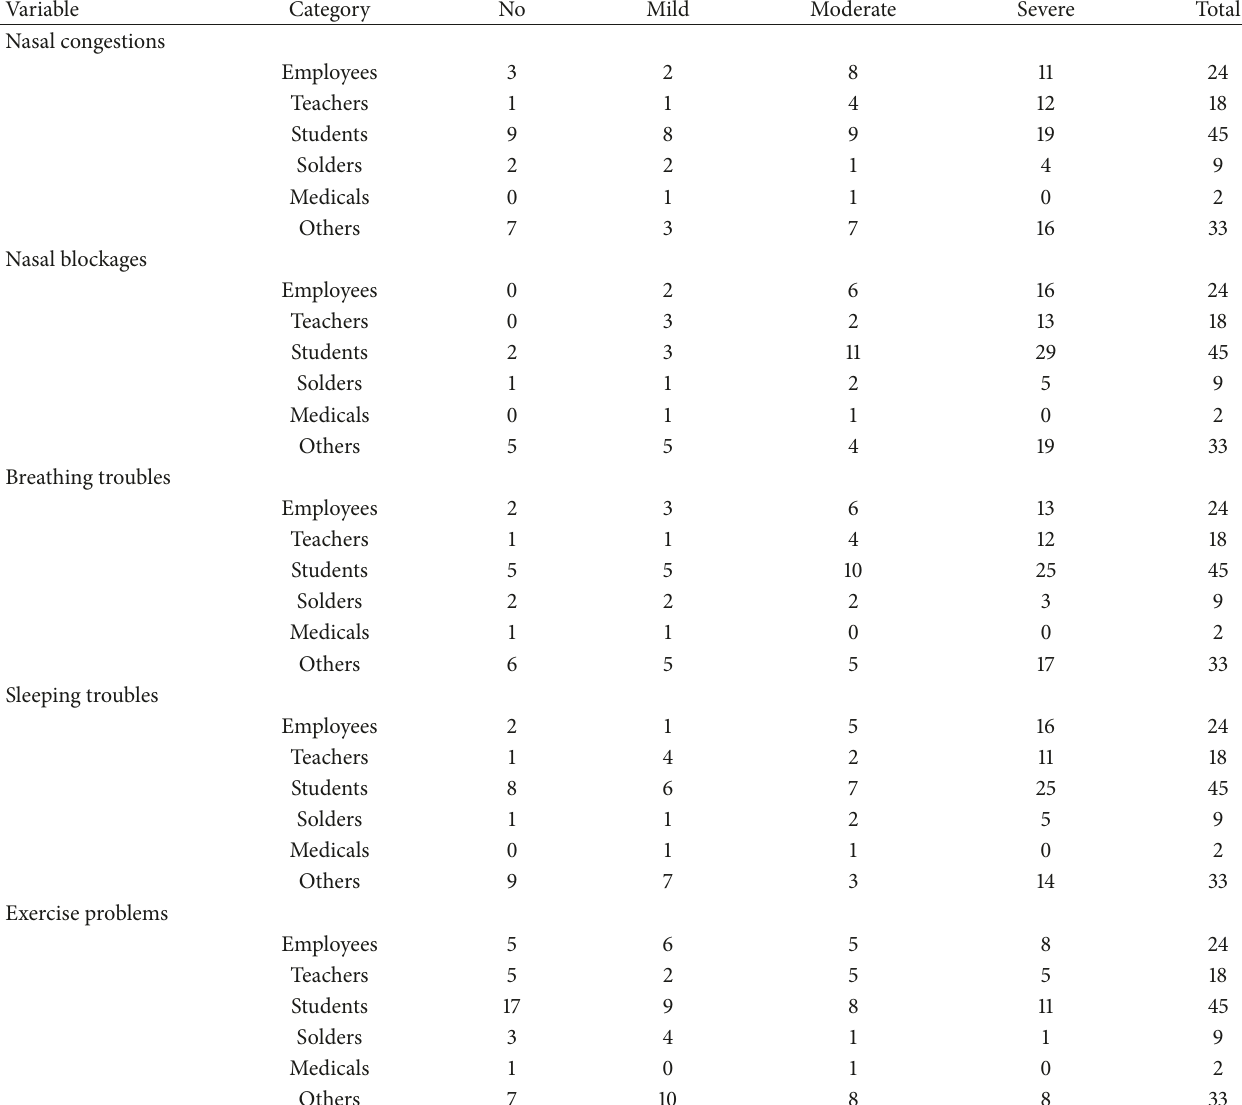
Table 5: Distribution of the study subjects by occupation and clinical